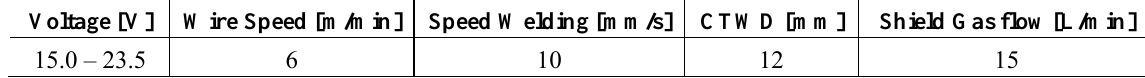
Table 1. Welding Parameters Set.